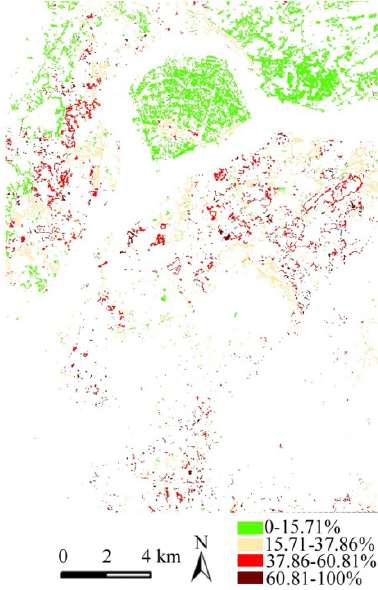
Figure 4. The pattern of the IR levels.